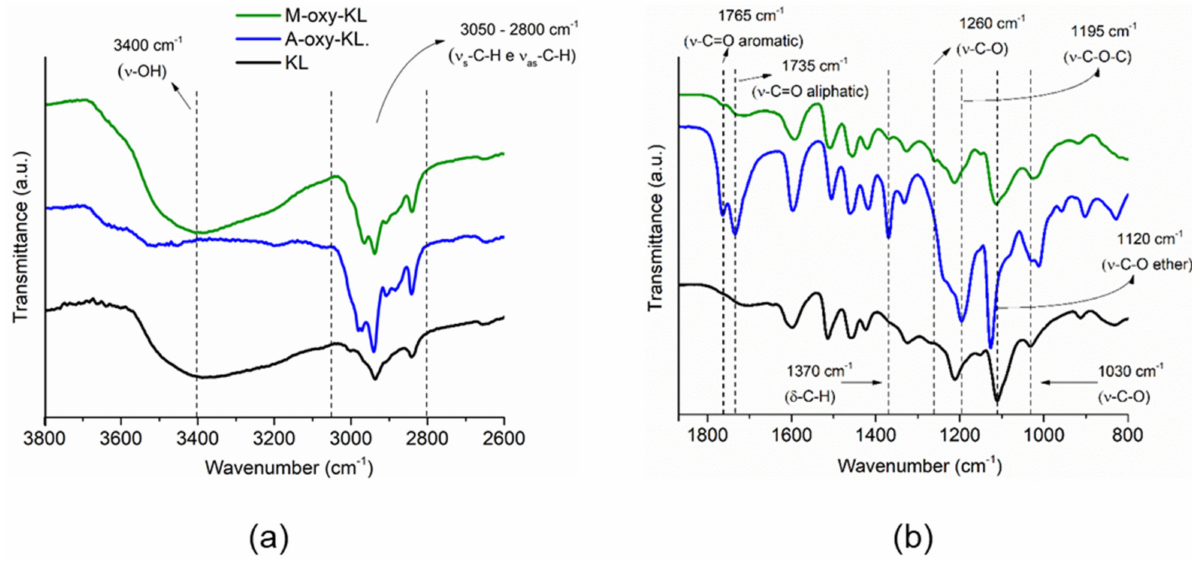
Figure 2. Fourier-transform infrared (FTIR) spectra of KL, A-oxy-KL and M-oxy-KL. ( a ) 3800–2600; ( b )